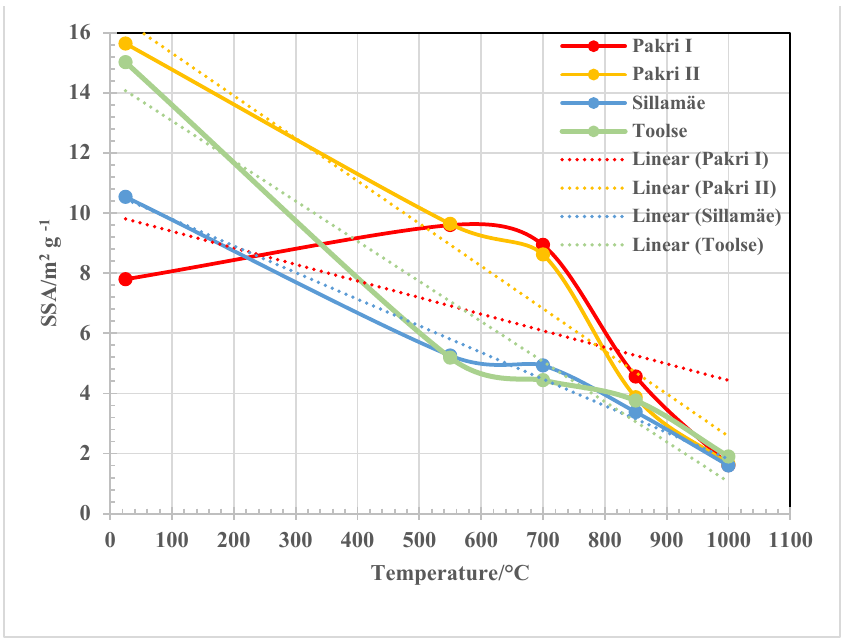
Figure 8. Changes in SSA values depending on the treatment temperature of GA samples.